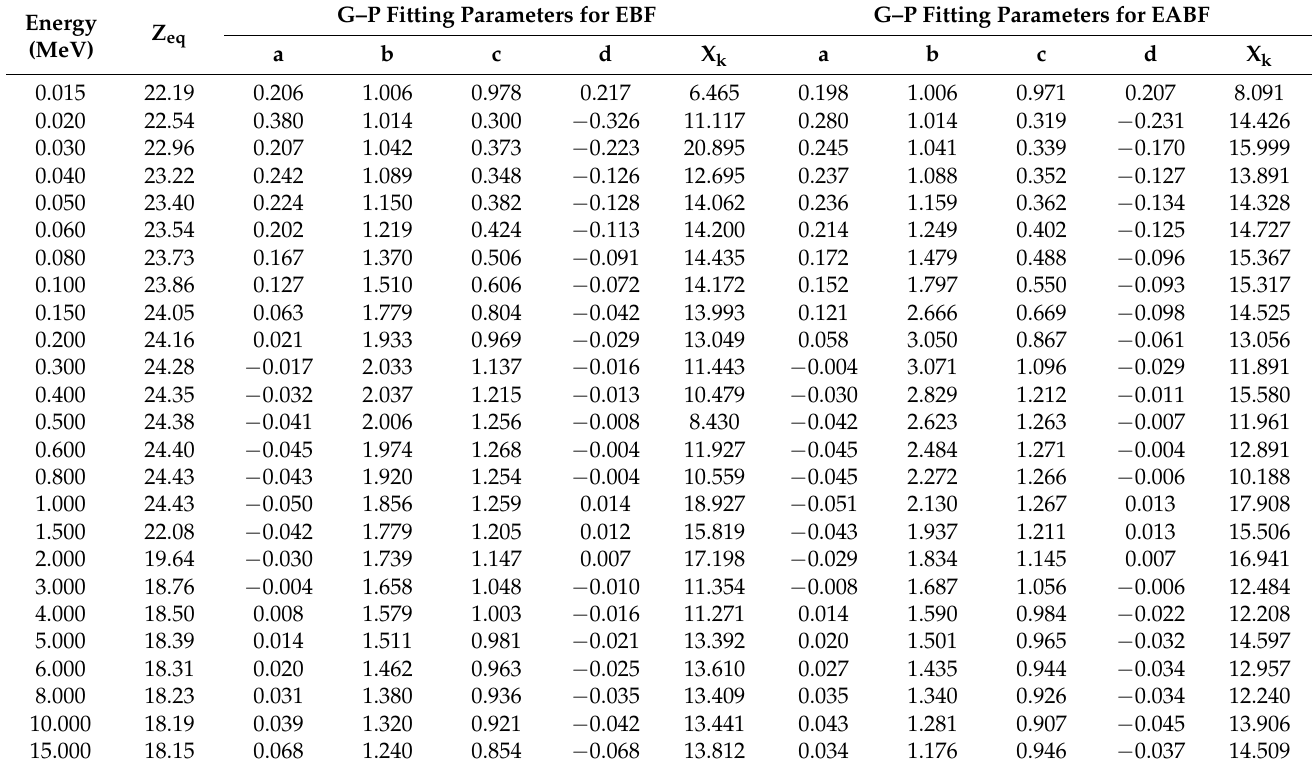
Table 6. (EBF and EABF) G–P fitting coefficients for the ZBV4 glass